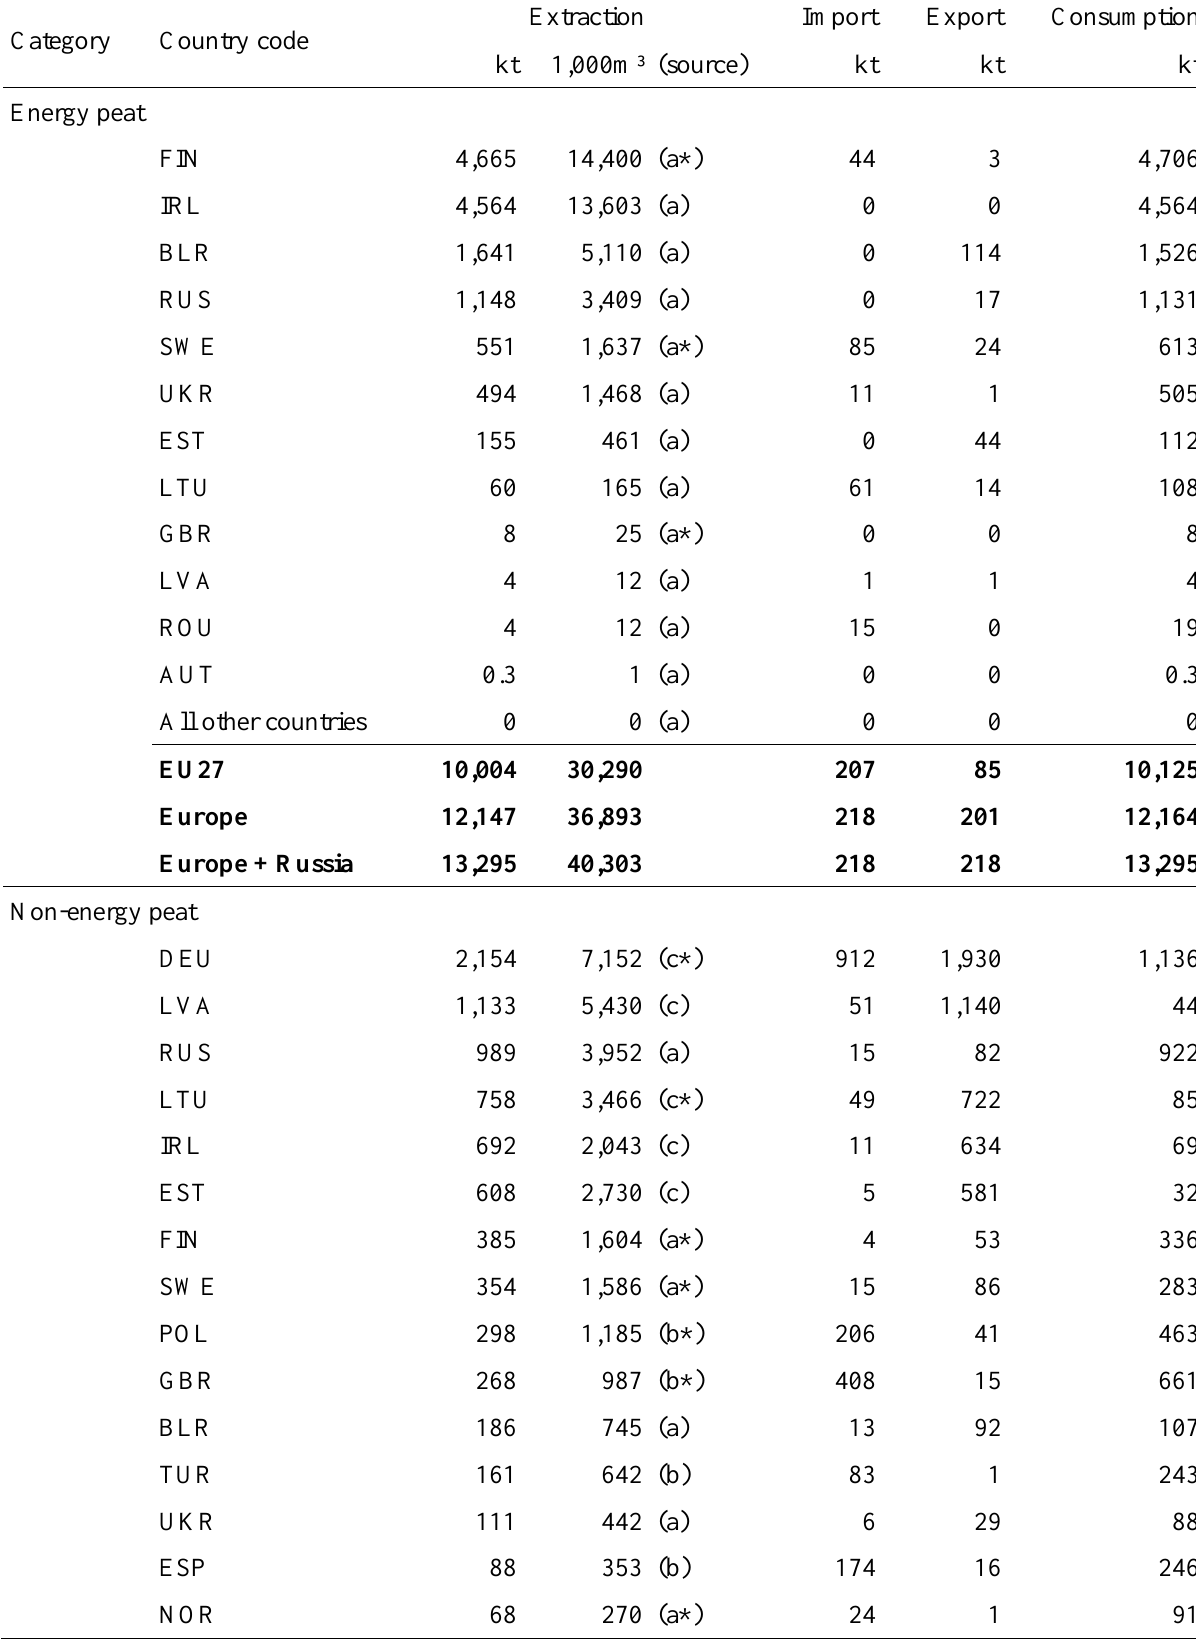
Table 1. Material balance of peat for energy and non-energy purposes for each country. Average amounts per year for the period 2013–2017. Country codes: ISO 3166 Alpha-3 code available at